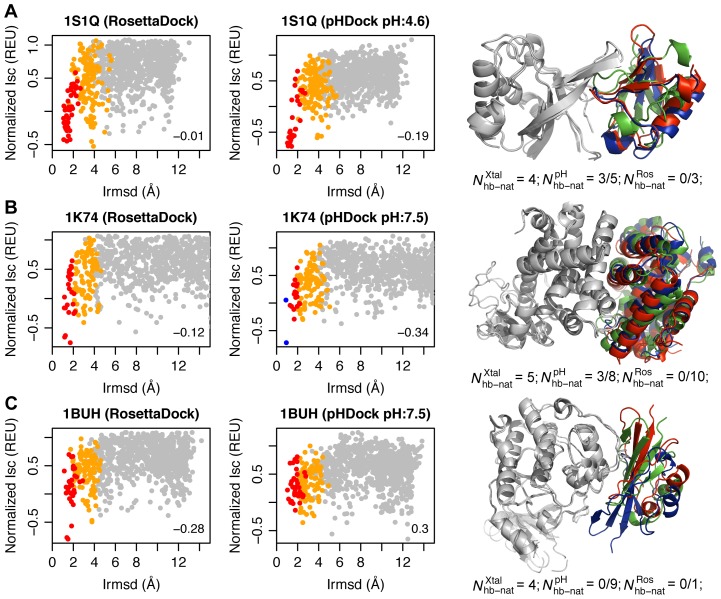
Hydrogen bonding recovery correlates with docking performance.Docking plots generated using RosettaDock and pHDock for (A) tumor susceptibility gene 101 protein–Ubiquitin complex (1S1Q; pH 4.6), (B) PPARgamma+RXRalpha–GW409544+co-activator peptide complex (1K74; pH 7.5), and (C) CDK2 kinase–cell cycle-regulatory protein CksHs1 complex (1BUH; pH 7.5). Grey, orange, red, and blue points represent incorrect, acceptable-, medium-, and high-quality models, respectively. Discrimination scores are shown in the bottom right corner of the plots. The right panel shows structures of the top pHDock (blue) and RosettaDock (green) models superimposed on the native complex (red). The number of native hydrogen bonds among the total interface hydrogen bonds observed in the bound crystal complex, and the top-scoring pHDockand RosettaDockmodels are also listed.